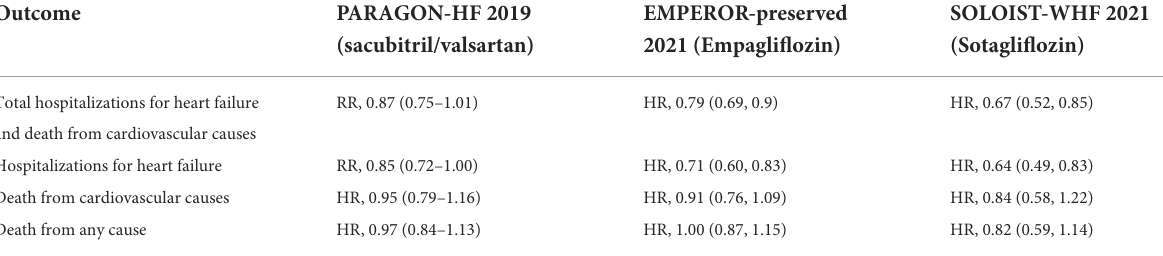
TABLE 3 The difference between the end-point of the PARAGON trial and of SGLT2i trials.